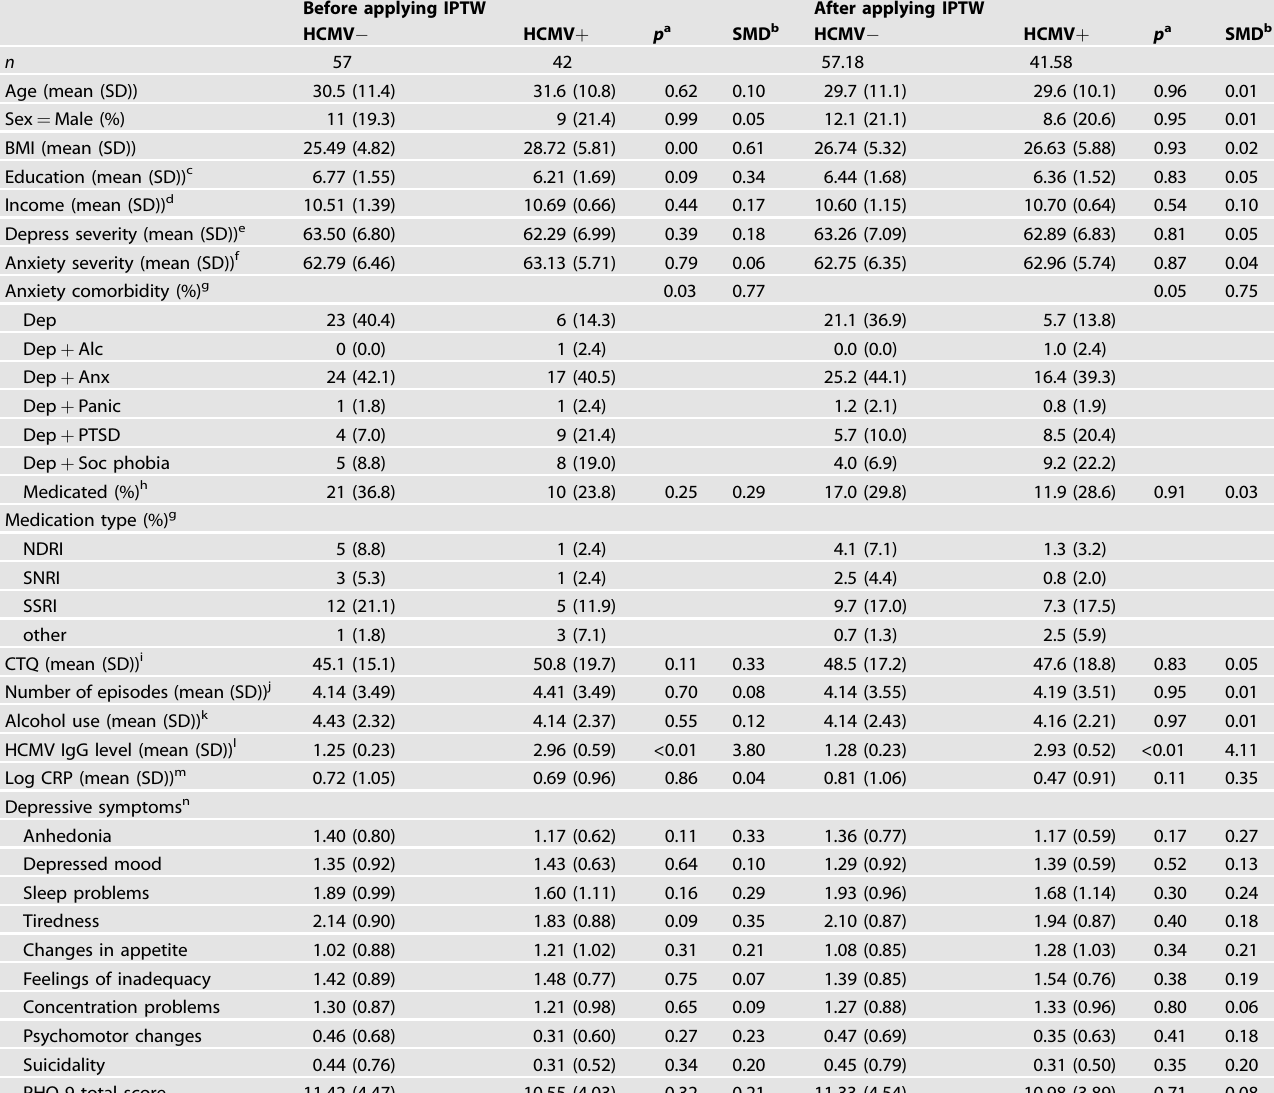
Table 1. Demographic and clinical characteristics of study participants before and after applying inverse probability of treatment weighting (IPTW). Before applying